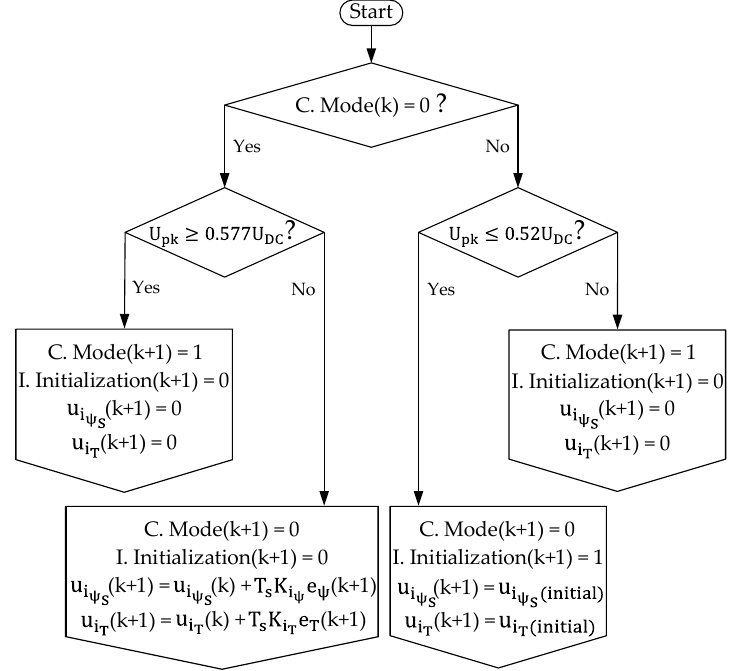
Figure 14. Control mode selection algorithm.